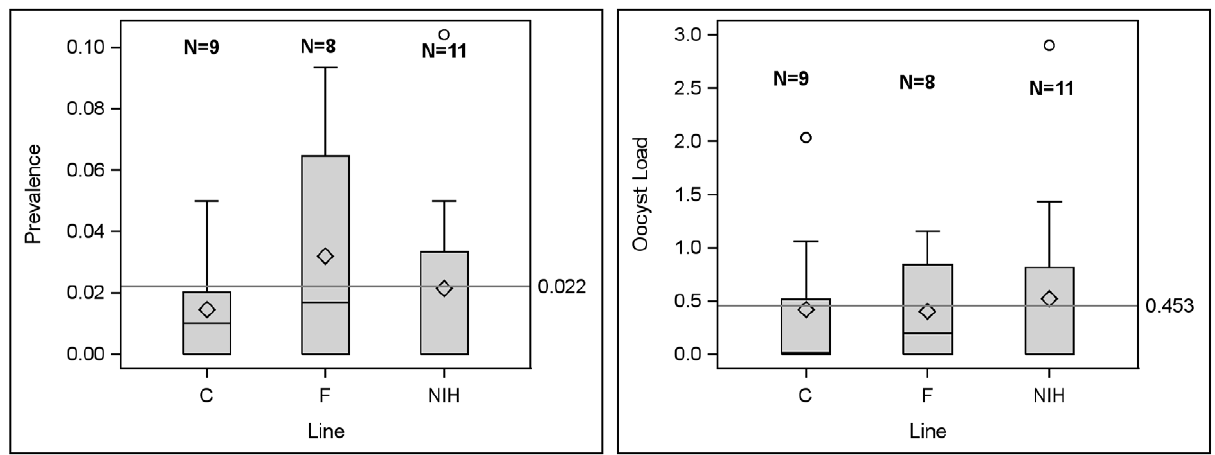
Figure 3. Infection prevalence and intensity in unselected lines of An.Stephensi . Anopheles stephensi prevalence and mean oocyst load in unselected lines over a total of 28 infection experiments. Overall mean is shown by the horizontal line. Number of experiments is shown above each box-whisker plot (sample size range per experiment 50–175, except n=20 in one experiment with the NIH line). The differences among lines in overall prevalence was not significant ( x 2=3.96, df=2, P , 0.137) as was the case for the oocyst load (ANOVA with Experiment treated as blocking factor: F 2,2135 =0.58, P . 0.55).